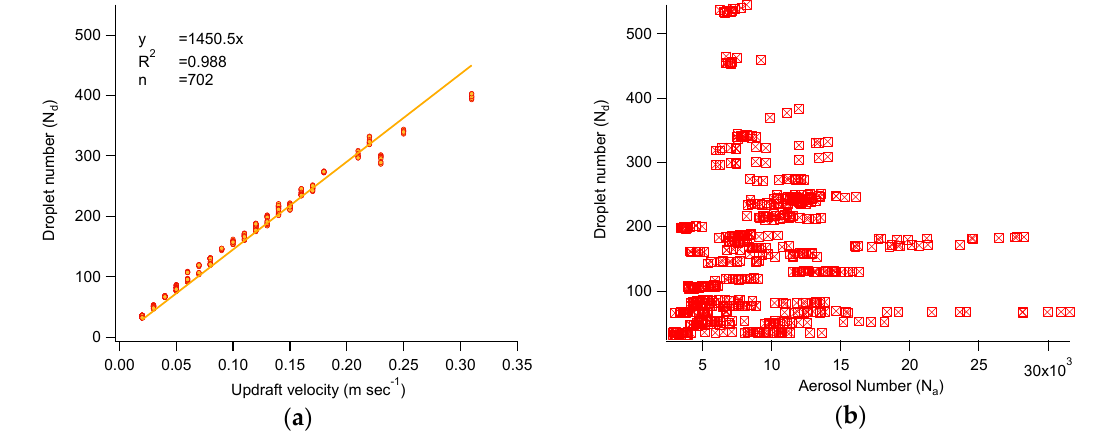
Figure 6. Correlation of droplet number with updraft velocity ( a ) and total aerosol number ( b ) during Period 1, when updraft velocities were low and aerosol numbers were high.